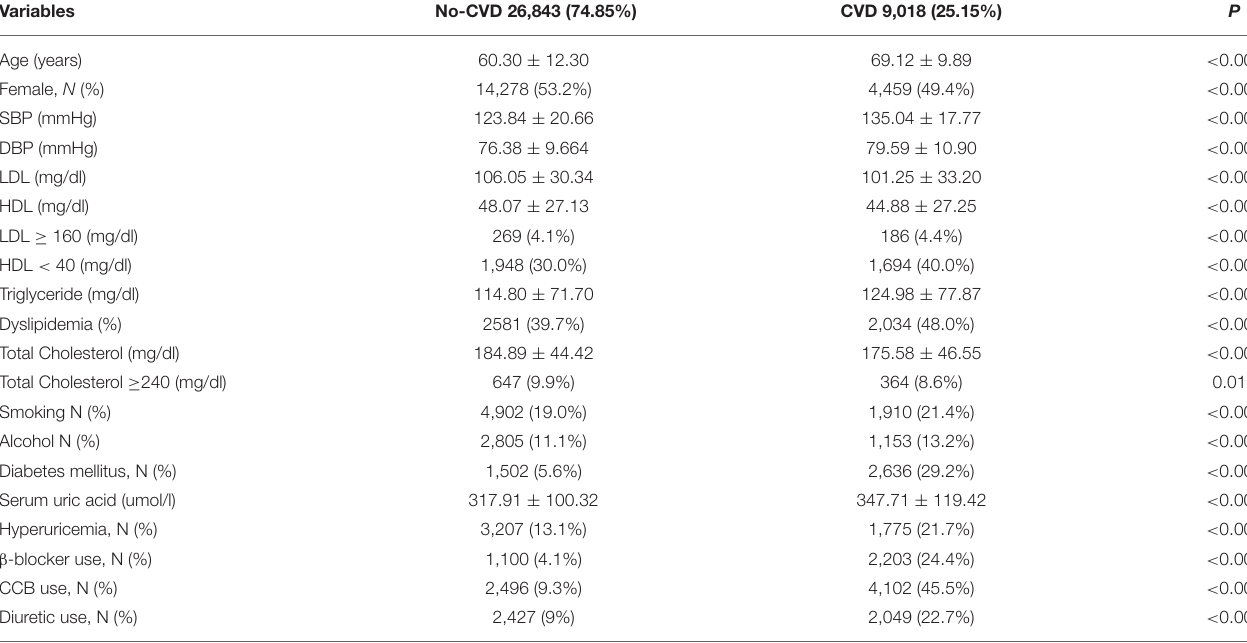
TABLE 1 | Baseline characteristics of the participants, ( N = 35,861). Variables